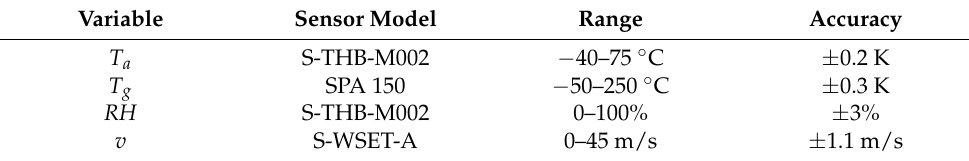
Table 1. The specification of sensors for assembly movable microclimate monitor.